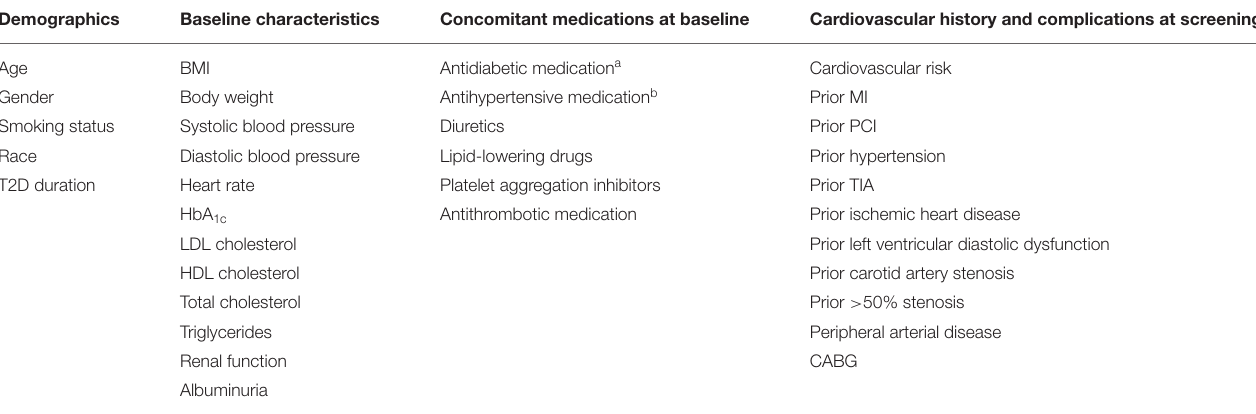
TABLE 1 | Characteristics evaluated as potential contributors for impact on time to first MACE in US population and non-US populations. Demographics